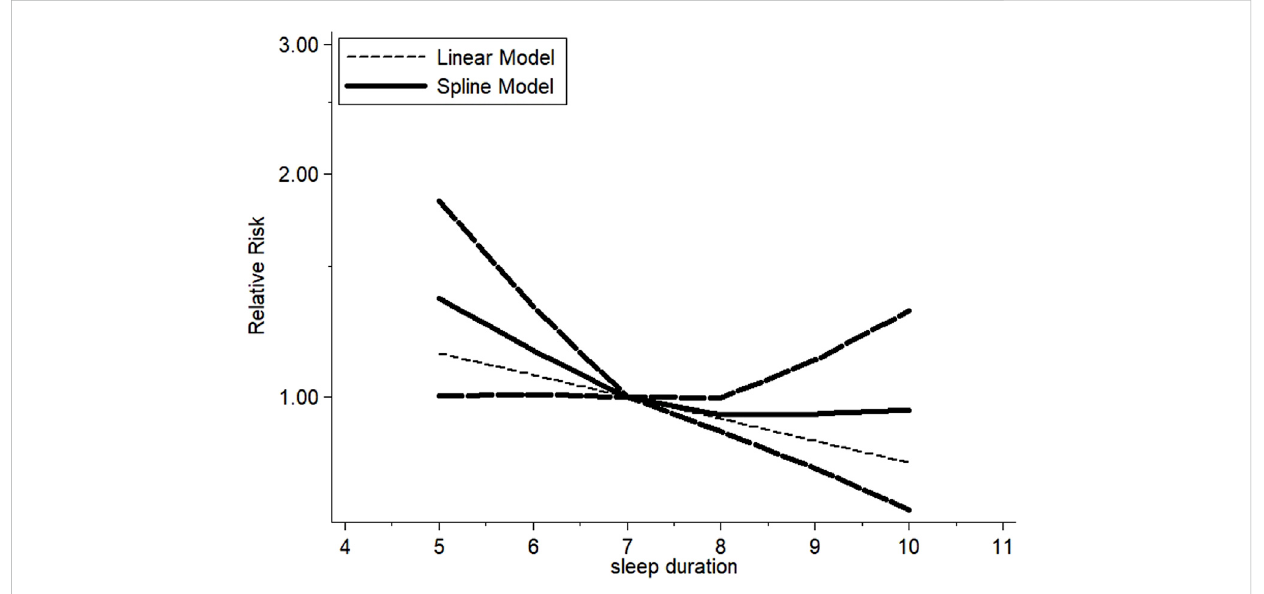
FIGURE 3 Dose – response meta-analysis of sleep duration and depression risk.